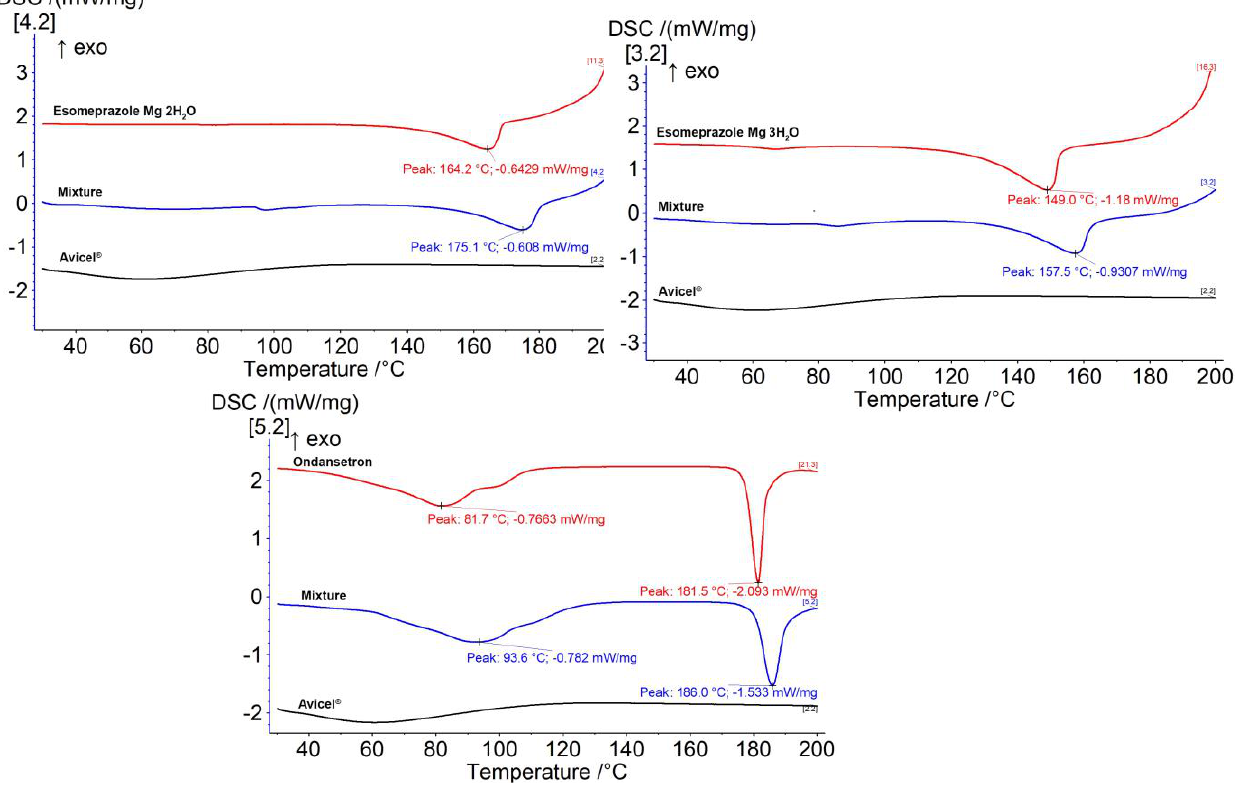
Figure 4. DSC thermograms of single materials (MCC, esomeprazole Mg 2H 2 O, esomeprazole Mg 3H 2 O and ondansetron) and physical mixtures of MCC and APIs (50:50).